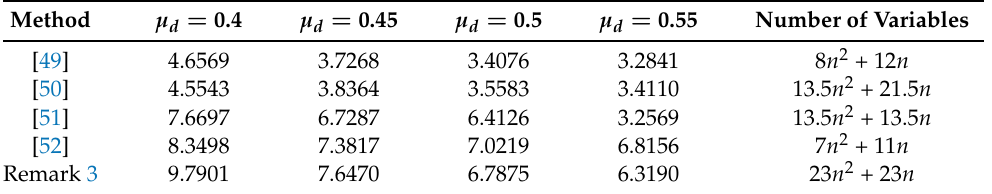
Table 2. Allowable upper bound µ M for various µ d of Example 5.